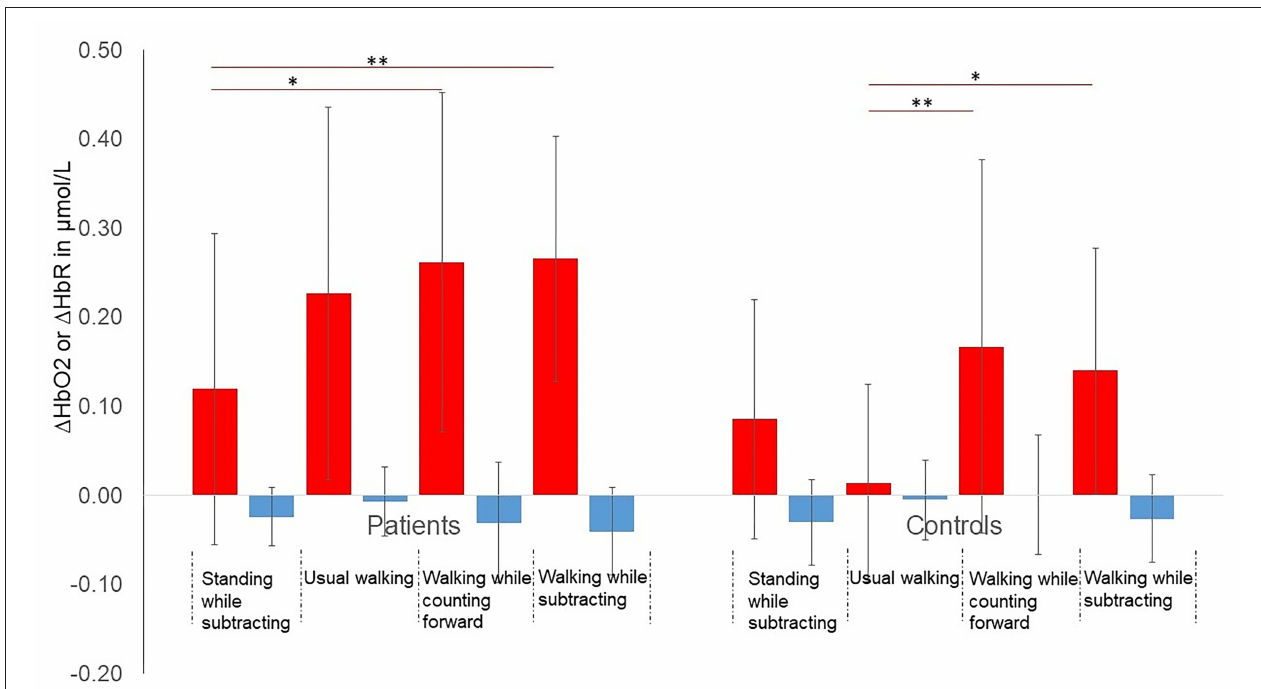
FIGURE 2 | Mean (SD) changes ( 1 ) in HbO 2 and HbR during the 4 conditions in both groups. * p < 0.05, ** p < 0.01. P -values adjusted for Bonferroni correction. Red bars represent 1 HbO 2 and blue bars represent 1 HbR. Red lines represent significant within-group differences in 1 HbO 2 between 2